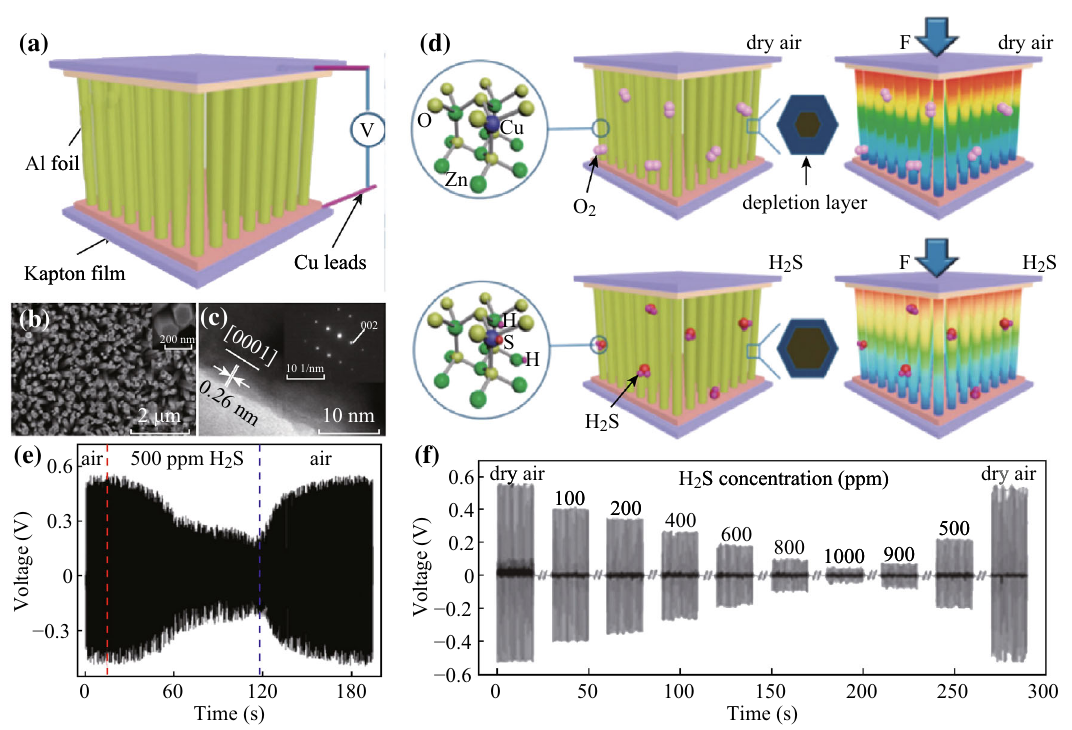
Fig. 3 High response and selectivity of a Cu–ZnO NW PENG as a self-powered/active H 2 S sensor. a Schematic of a Cu–ZnO NW PENG as a self-powered/active H 2 S sensor. b SEM image of 5 at% Cu–ZnO NWs in top view. c HRTEM image and the SAED pattern of the edge region of a 5 at% Cu–ZnO NW. d Working mechanism of Cu–ZnO NW PENG as a self-powered/active H 2 S sensor. e A continuous responding- recovering process of the device against 500 ppm H 2 S. f Piezoelectric output voltage of the device under compressive force at room temperature in dry air and various concentrations of H 2 S. Figures adapted from